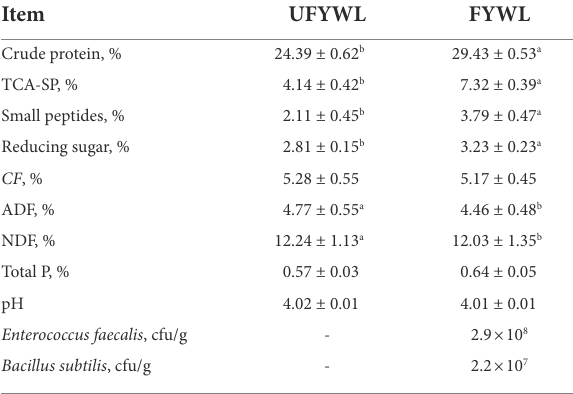
TABLE 1 The chemical analysis of the UFYWL and